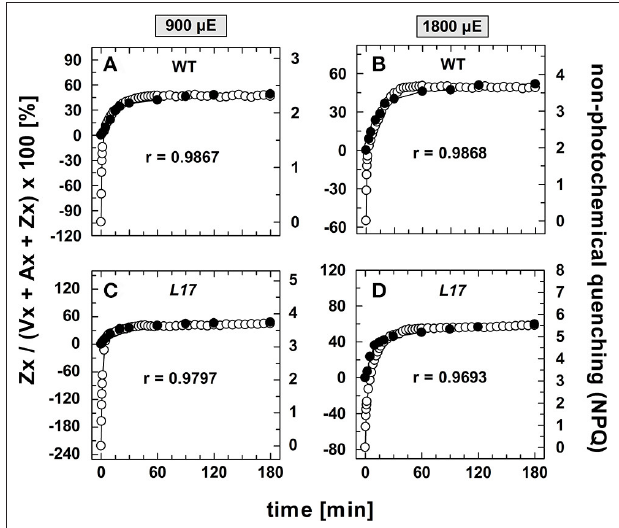
FIGURE 5 | Comparison of the kinetics of NPQ induction and Zx synthesis in WT and L17 plants. The data for NPQ induction (open circles) and Zx synthesis (filled circles) are compared for WT plants (A,B) and L17 plants (C,D) at 900, (A,C) and 1,800 µ E (B,D) . For direct comparison, the data for Zx synthesis were fitted to match the amplitudes of the slowly developing ( > 2min) NPQ components, only. The data were taken from Figure 1 (NPQ) and Figure 3 (Zx). The determined Pearson’s correlation coefficient r is indicated in each